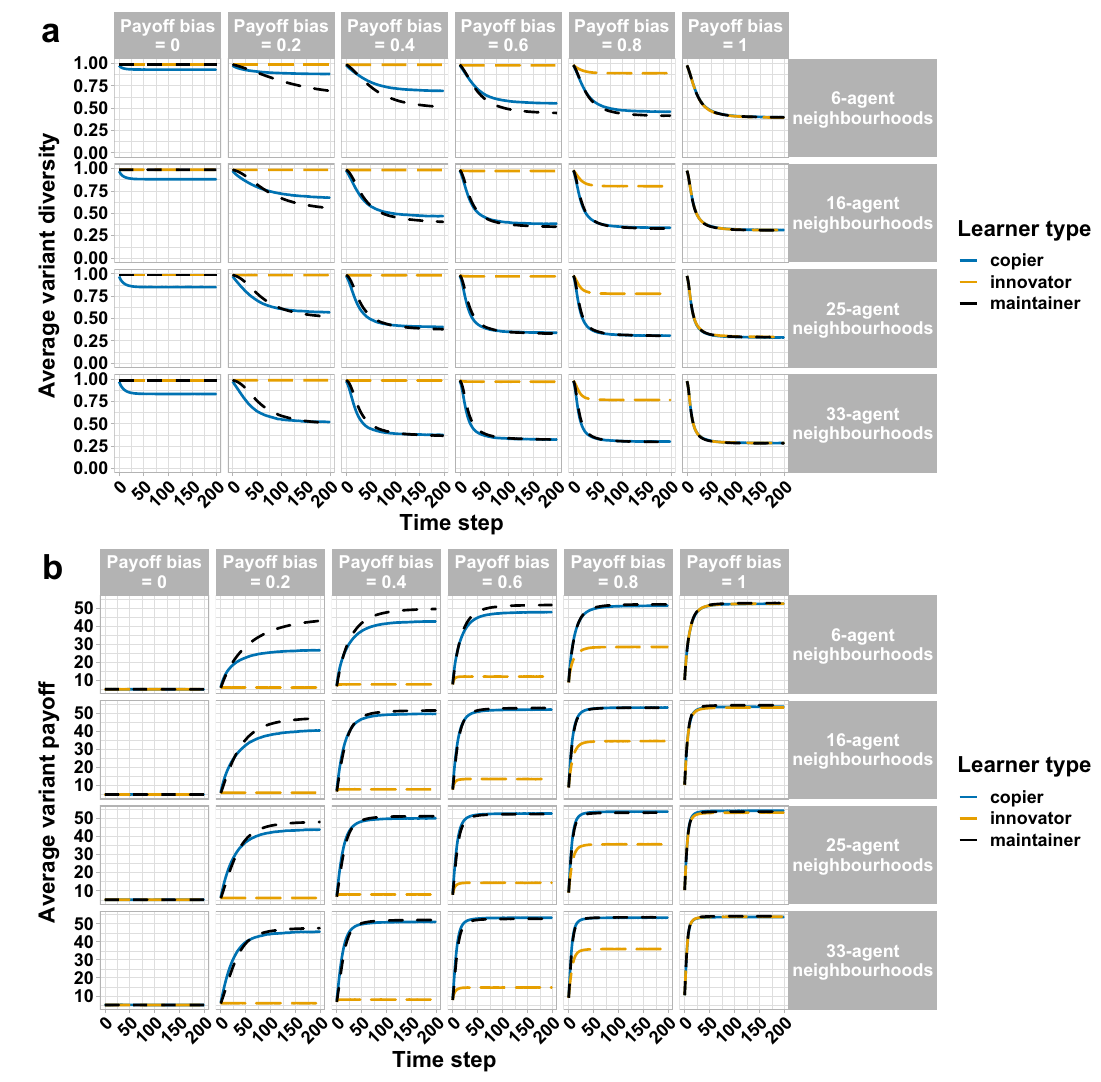
Figure 4. Change in cultural diversity ( a ) and average variant payoff (adaptation) ( b ) over 200 time steps as a function of the different parameter combinations (payoff bias, learner type and neighbourhood size). The number of agents in each neighbourhood is approximate (see “Method” section). Each population had 200 agents. Variant diversity was measured by the Gini-Simpson index of diversity (maximum for 200-agent populations = 0.995). Each line is the average of 10,000